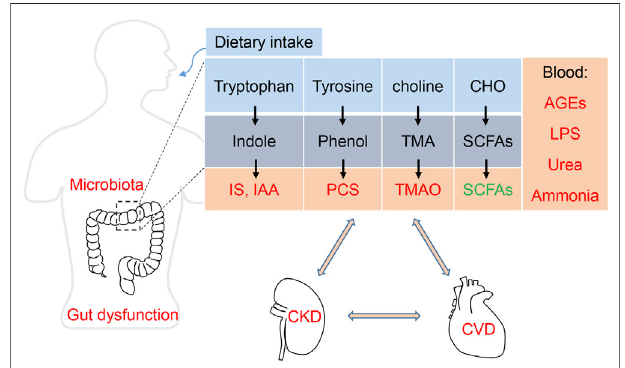
FIGURE 2 | Uremic toxins in the gut-kidney-heart